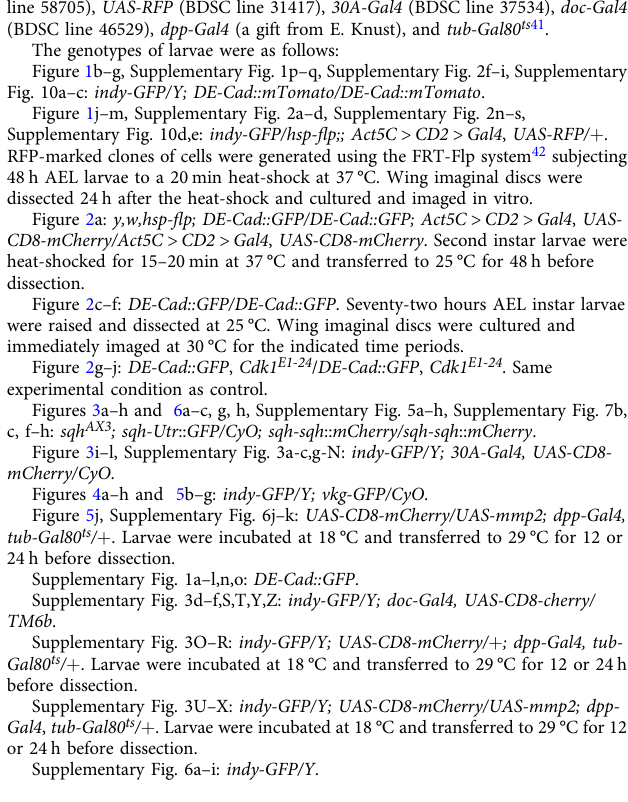
dissection. Figure 2c – f: DE-Cad::GFP/DE-Cad::GFP . Seventy-two hours AEL instar larvae were raised and dissected at 25 °C. Wing imaginal discs were cultured and